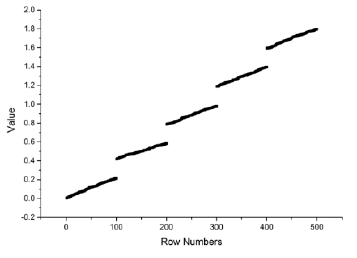
Figure 1. Distribution of simulated